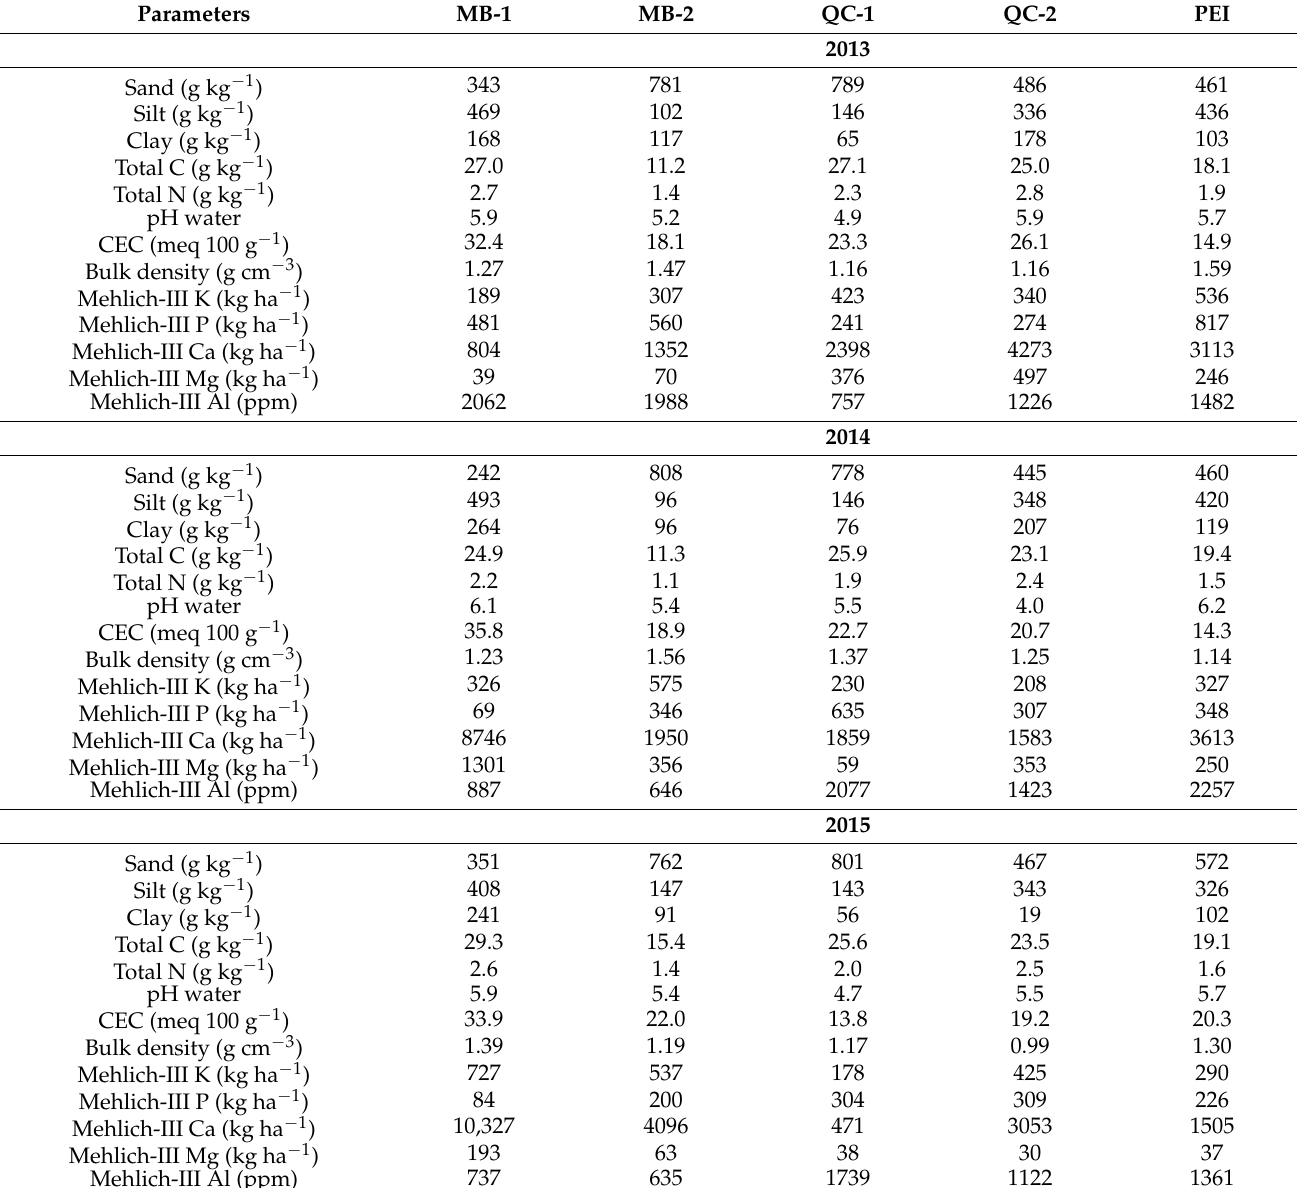
Table 2. Selected soil fertility related parameters (0–20 cm depth) prior to trial establishment.